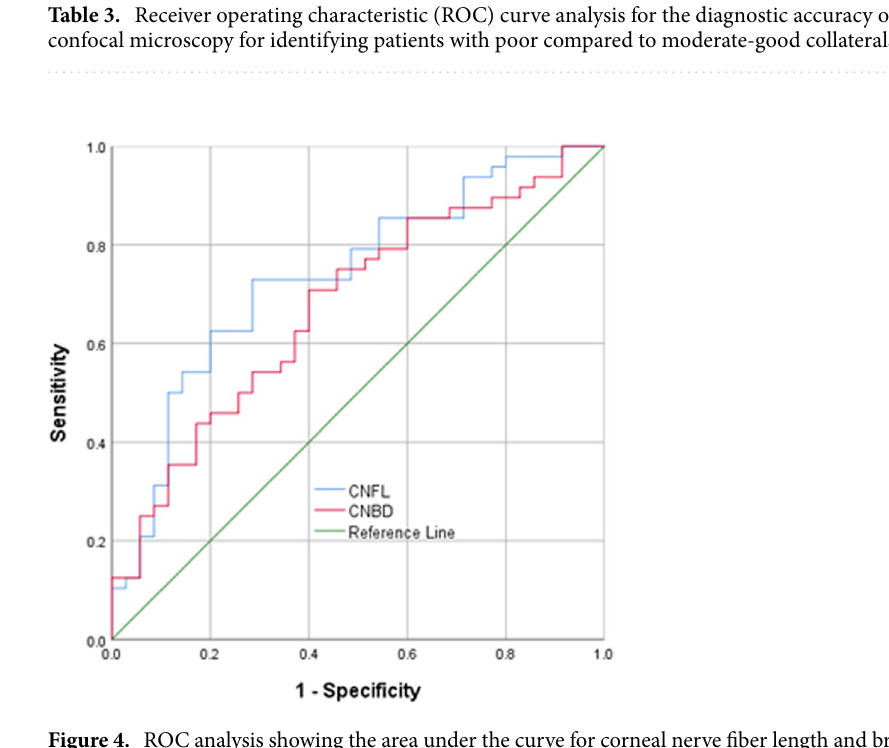
Figure 4. ROC analysis showing the area under the curve for corneal nerve fiber length and branch density for differentiating patients with poor from those with moderate-good pial